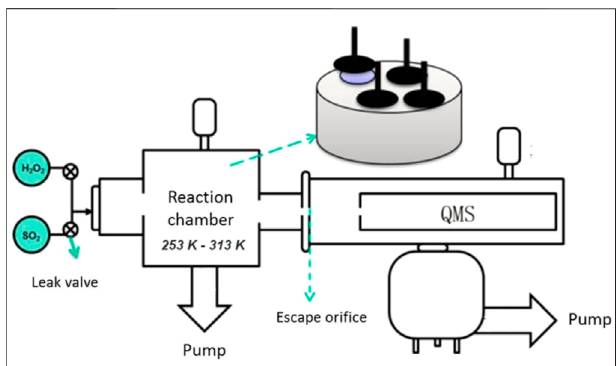
FIGURE 2 | Graphical scheme of the Knudsen cell